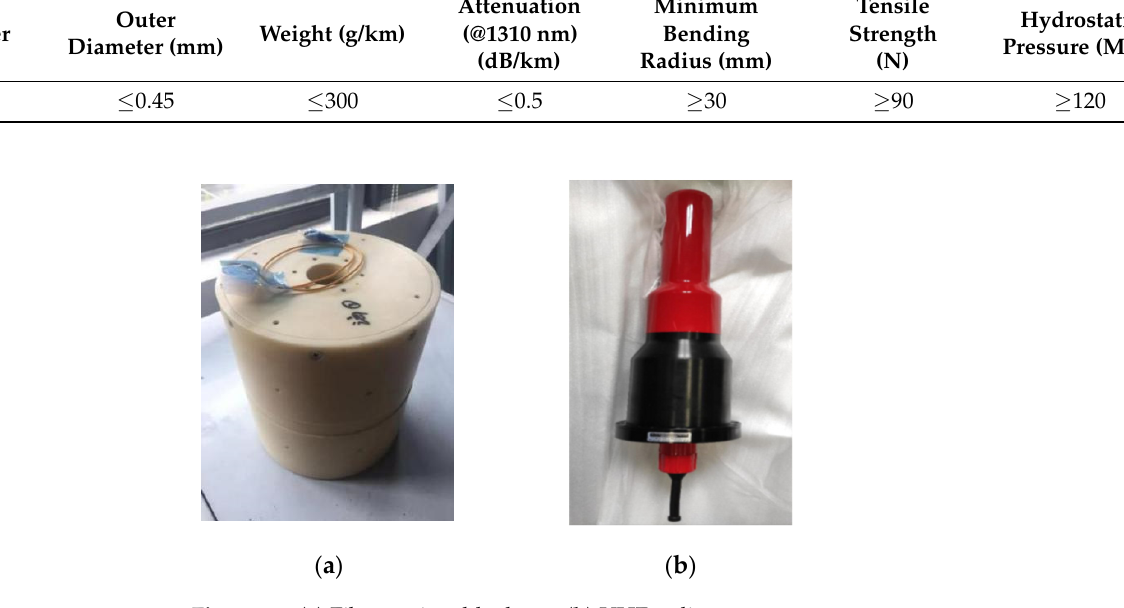
Figure 12. ( a ) Fiber optic cable drum; ( b ) UHF radio.